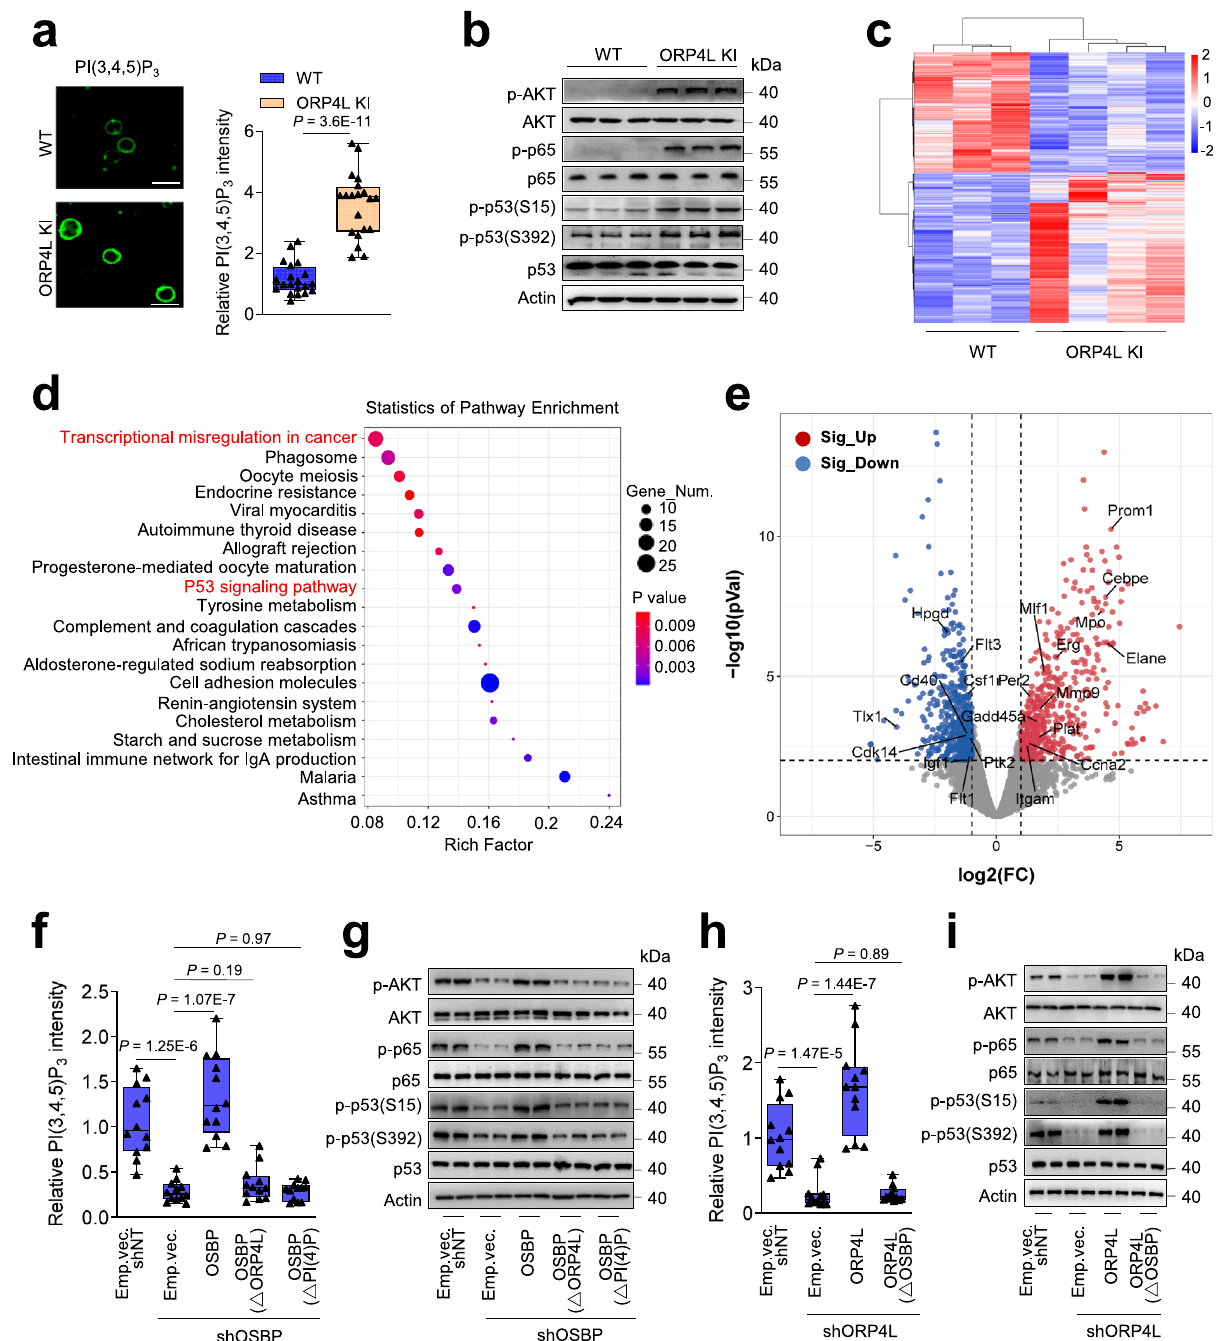
Fig.5|ORP4LenhancesPI(3,4,5)P 3 generationandAKTactivation.a PI(3,4,5)P 3 contentsinT-cellsofORP4LKIandlittermatewild-typemice.Scalebar,10 μ m.The right panels indicate quantitation of relative fl uorescence intensity. Black triangles present in dividual data points for n =20 cells from one mouse. b Phosphorylated AKT, p65 and p53 levels in T-cells of ORP4L KI and littermate wild-type